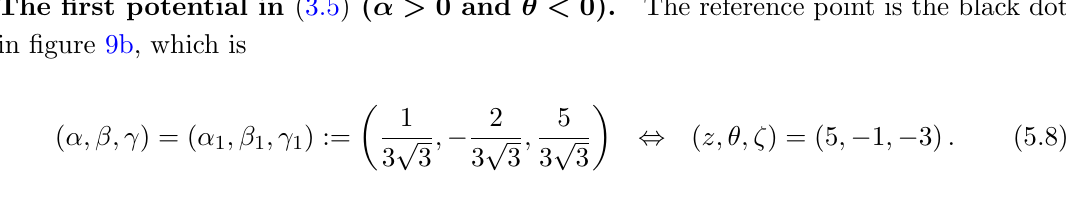
di(cid:11)erent from the black dot. Indeed, it is true as shown in the purple curve in (cid:12)gure